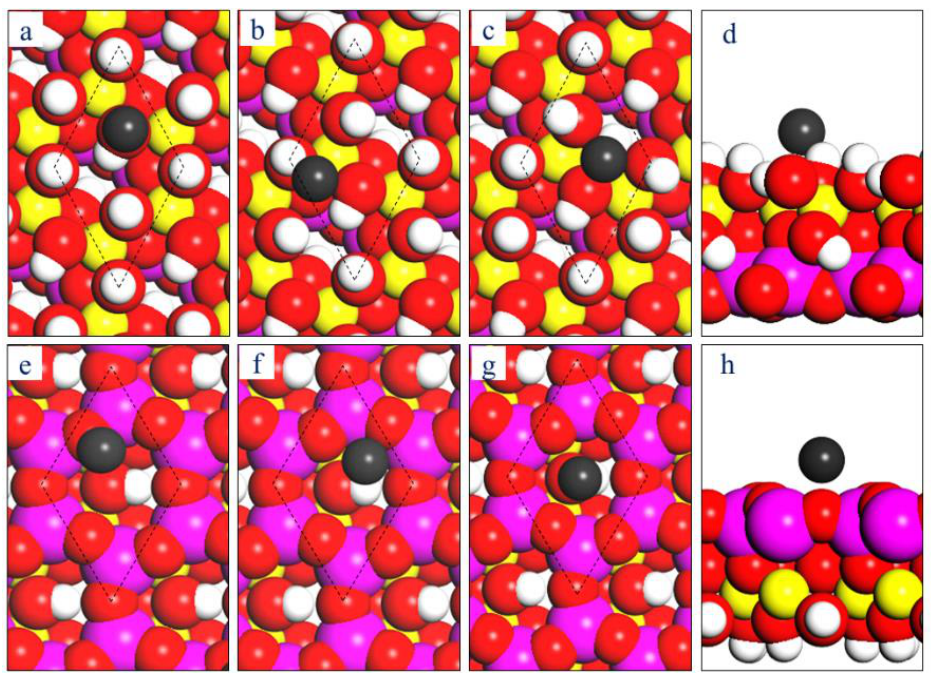
Figure 2. Top ( a ) and side ( d ) view of adsorbed Y (Nd or La) atoms on the top sites of kaolinite (001) surface, adsorbed Y (Nd or La) atoms on the ( b ) bridge sites, and adsorbed Y (Nd or La) atoms on the ( c ) hollow sites. Top ( e ) and side ( h ) view of Nd atoms adsorbed on the top site (Figure S1) of kaolinite ( 001 ̄) surface, adsorbed La (Y) atoms on the ( f ) bridge sites and adsorbed Nd (Y) atoms on the ( g ) hollow site. Here, adsorbed Y, Nd, and La atoms are colored dim grey for clarity. Table 1. The adsorption energy E ads (kJ/mol) of REEs (REEs = Y, Nd, and La) adsorbed on the (001) surface of kaolinite at different coverages.